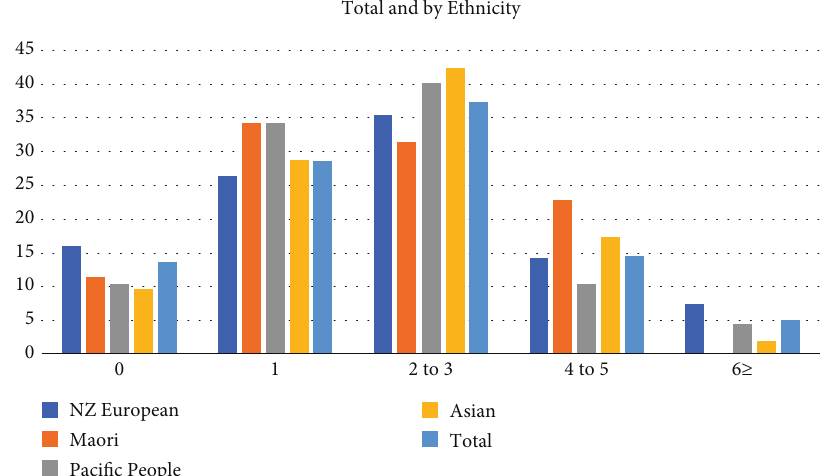
Figure 2: Number of lines of systemic treatment for ABC patients in Auckland